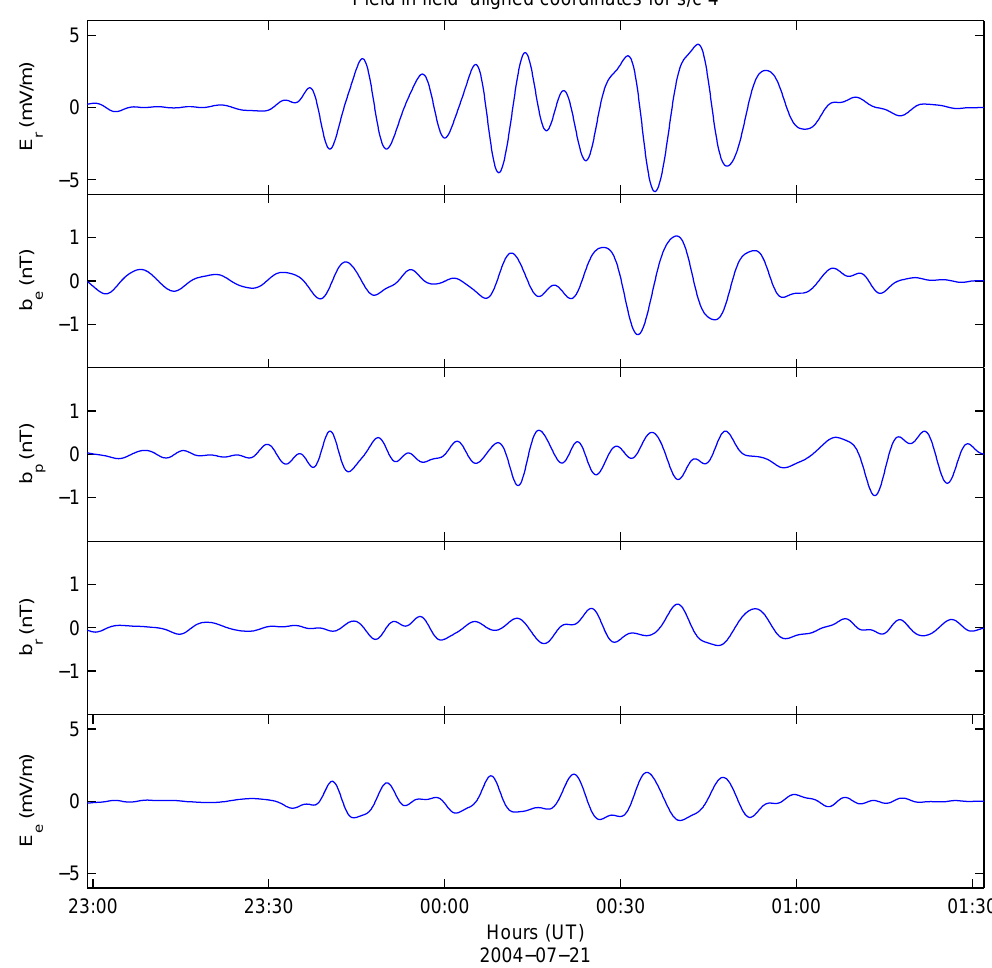
Fig. 4. Field in field-aligned coordinates for s/c